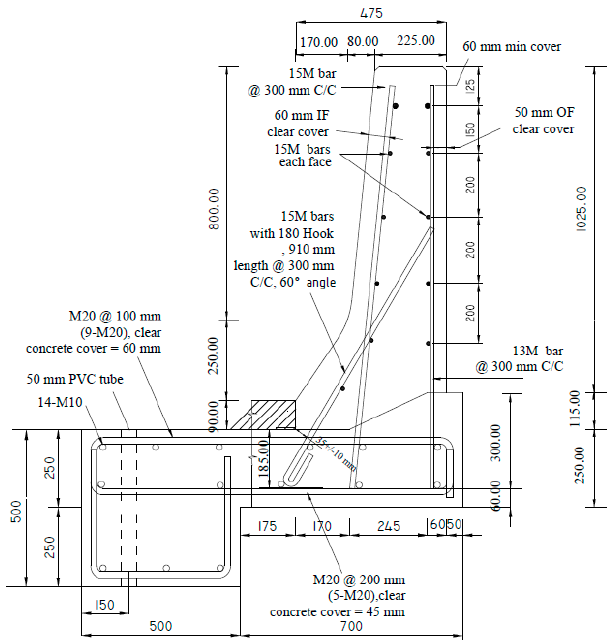
Figure 4. Specimen # 2: Interior location of barrier connected to a thin cantilever slab (hooks not facing roadway).